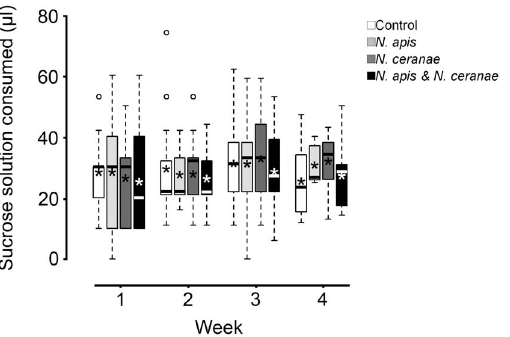
Figure 2. Effect of Nosema infection on adult worker western honey bee ( Apismellifera ) nutritional demand. Consumption is shown as volume of 50% (weight/volume) sucrose-water mixture per bee per week post inoculation for control, Nosema apis , Nosema ceranae , and mixed N. apis / N. ceranae treatments (Week 4 included only consumption from 22–25 d post inoculation). Boxplots show inter- quartile range (box), median (black or white line within interquartile range), data range (dashed vertical lines), and outliers (open dots); asterisks (black or white) represent means. No significant differences were observed among treatments for daily consumption per